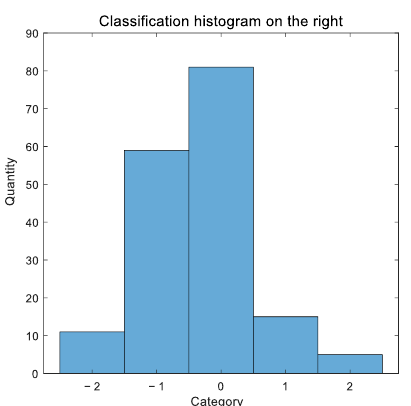
Figure 11. Classification histogram on the right.